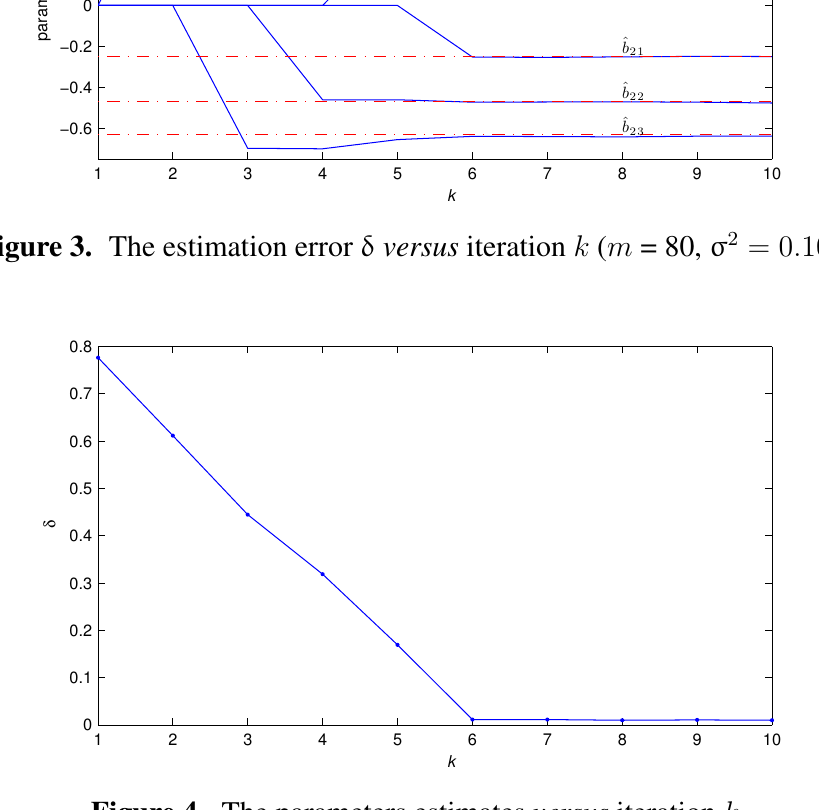
Figure 4. The parameters estimates versus iteration k